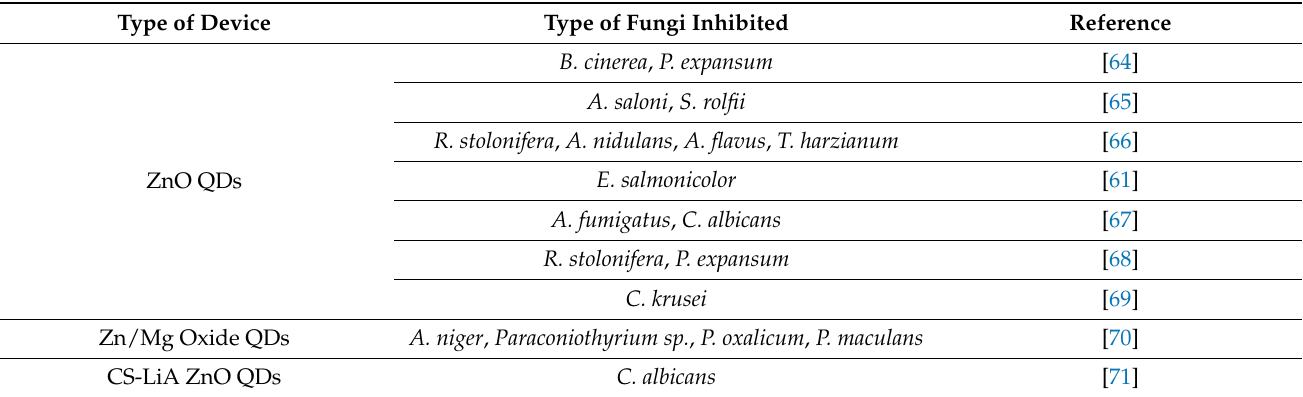
Table 2. Applications of ZnO QDs against